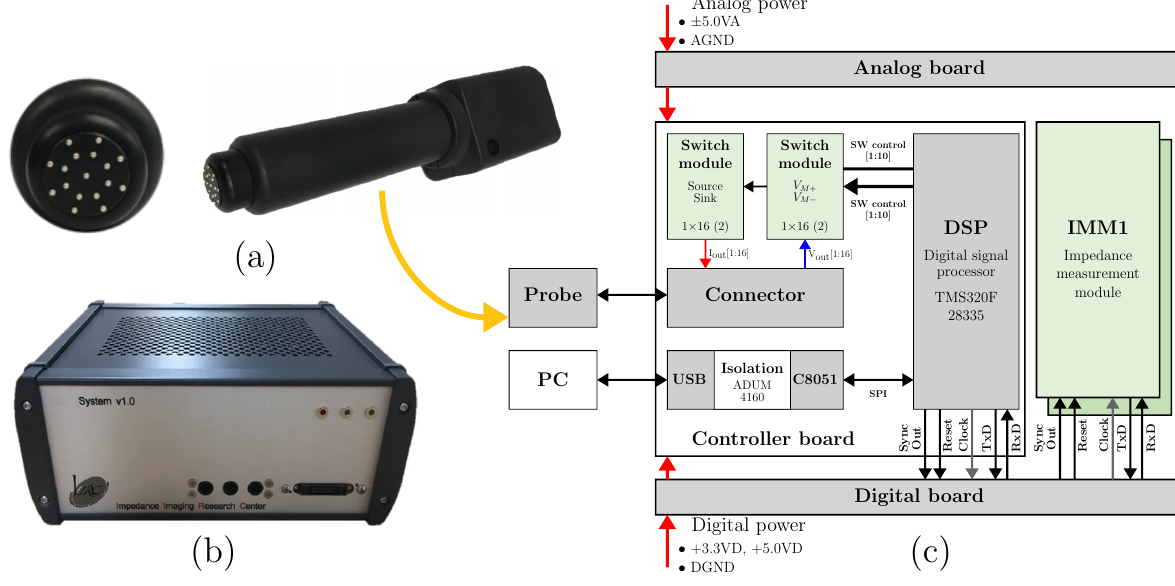
Figure 2. ( a ) Probe with multiple active electrodes. ( b ) Multi-channel electrical impedance spectroscopy. ( c ) The block diagram of the EIS